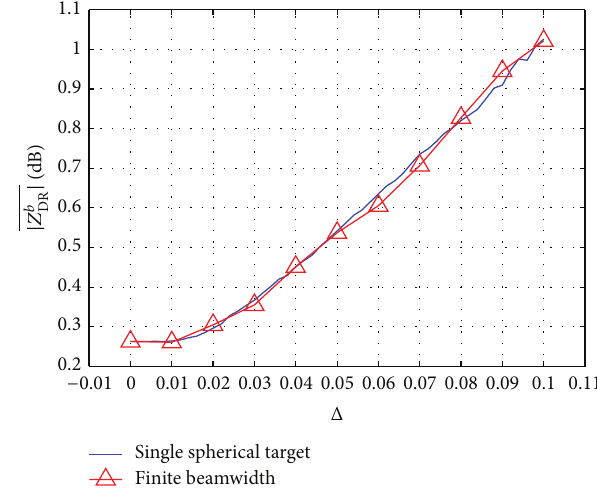
Figure 13: The impact of the channel coupling on |𝑍 𝑏 DR | .